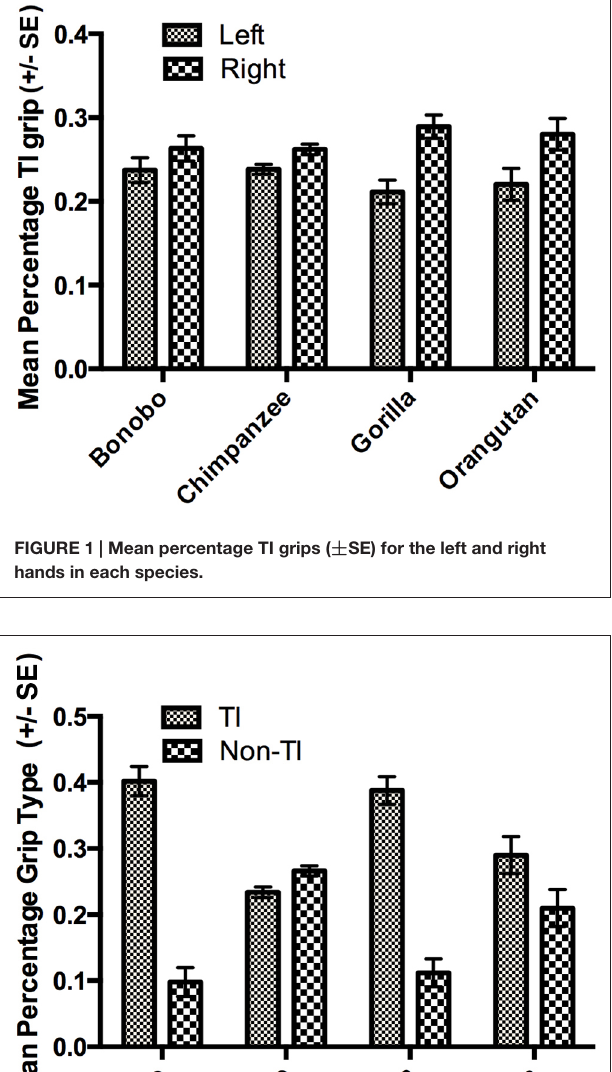
ANOVA. No significant main effects or interactions were found.